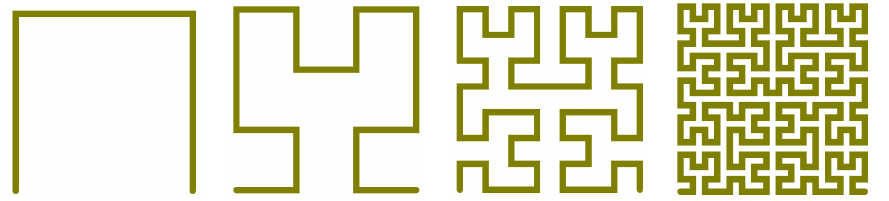
Figure 21. Four stages of the Hilbert fractal.